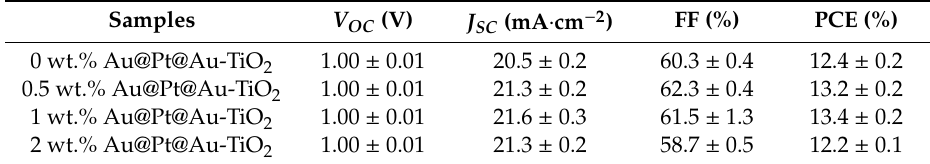
Table 1. Summarized photovoltaic parameters of di ff erent cells.